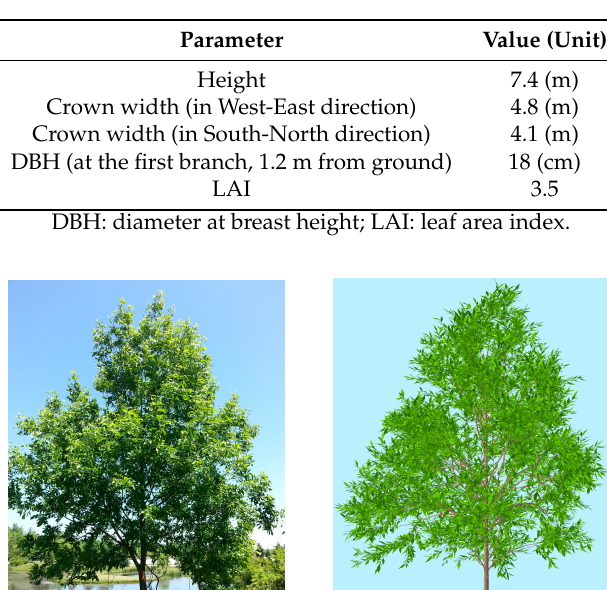
Table 1. The structural parameters of the ash tree.